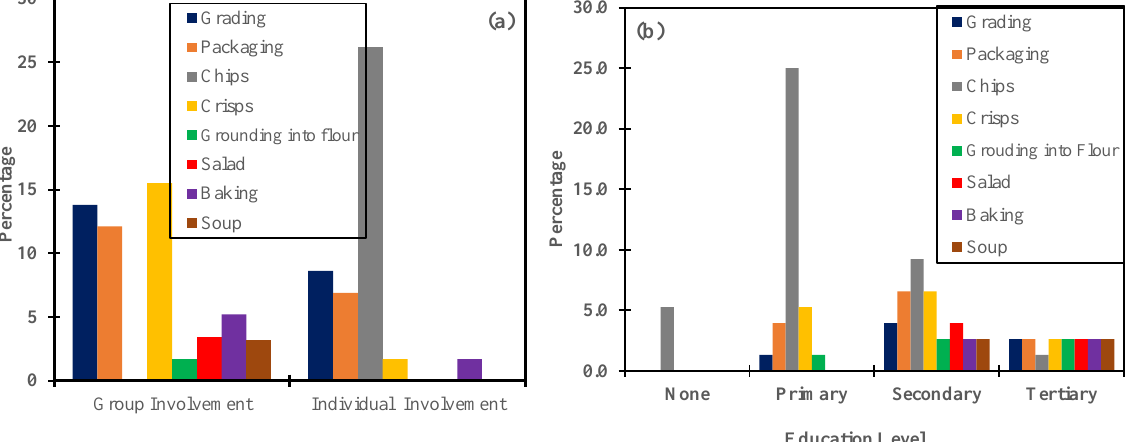
Figure 7. Influence of group participation (a) and education level (b) on Irish potato value addition practiced X 2 =4.997; df=3;